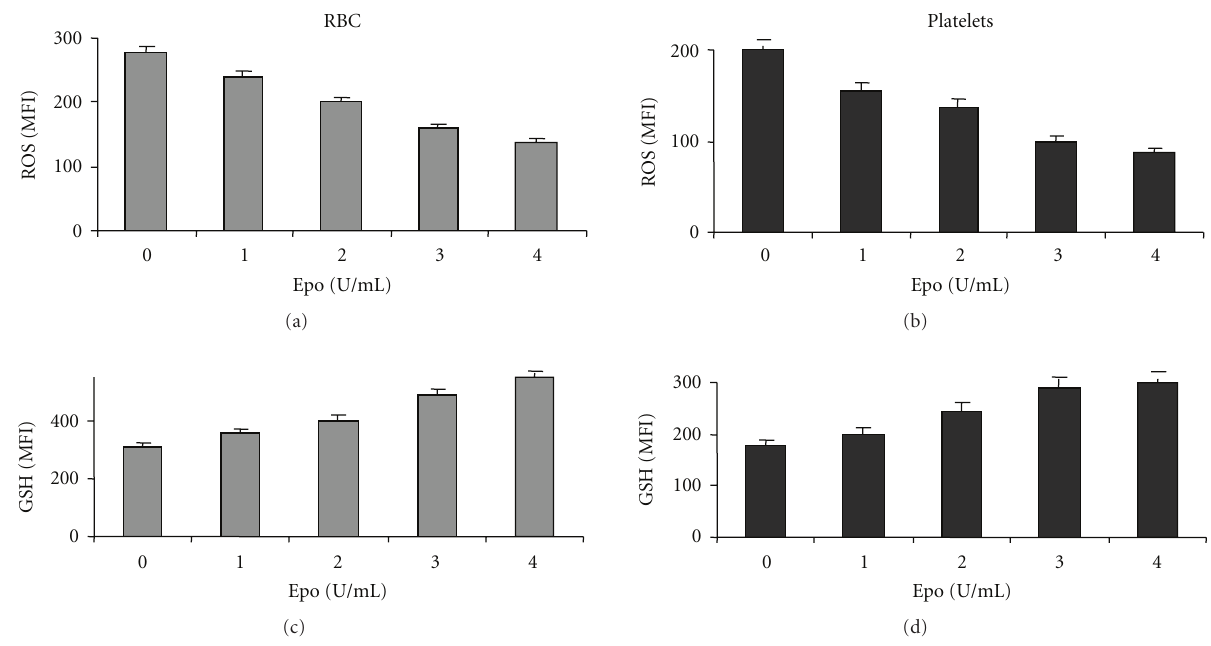
Figure 4: The Epo dose-e ff ect relationship on ROS and GSH of thalassemic RBC and platelets. Diluted blood samples were exposed to di ff erent concentrations of Epo for 2 hrs at 37 ◦ C and then stimulated with 1 mM H 2 O 2 for 15min. The results show the average ( N = 4) mean fluorescence index (MFI) ± SD of ROS and GSH in RBC and platelets.